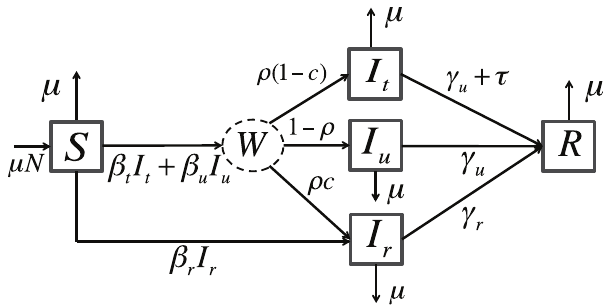
Figure 1. Compartmental Model for Eqs. (1)–(5).